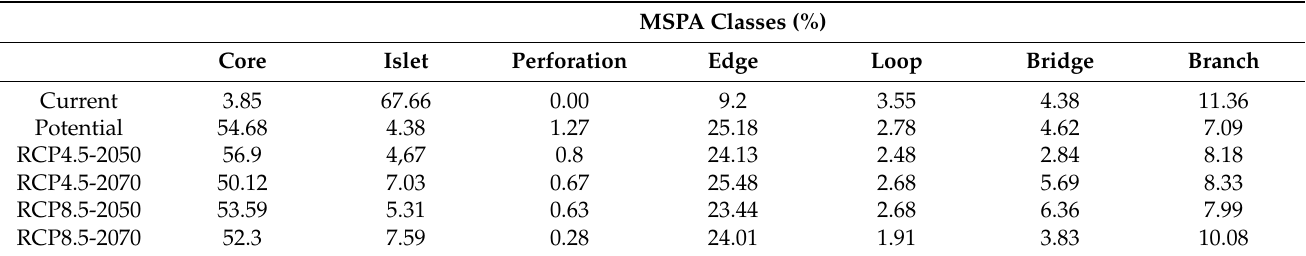
Table 1. Spatial change of MSPA classes